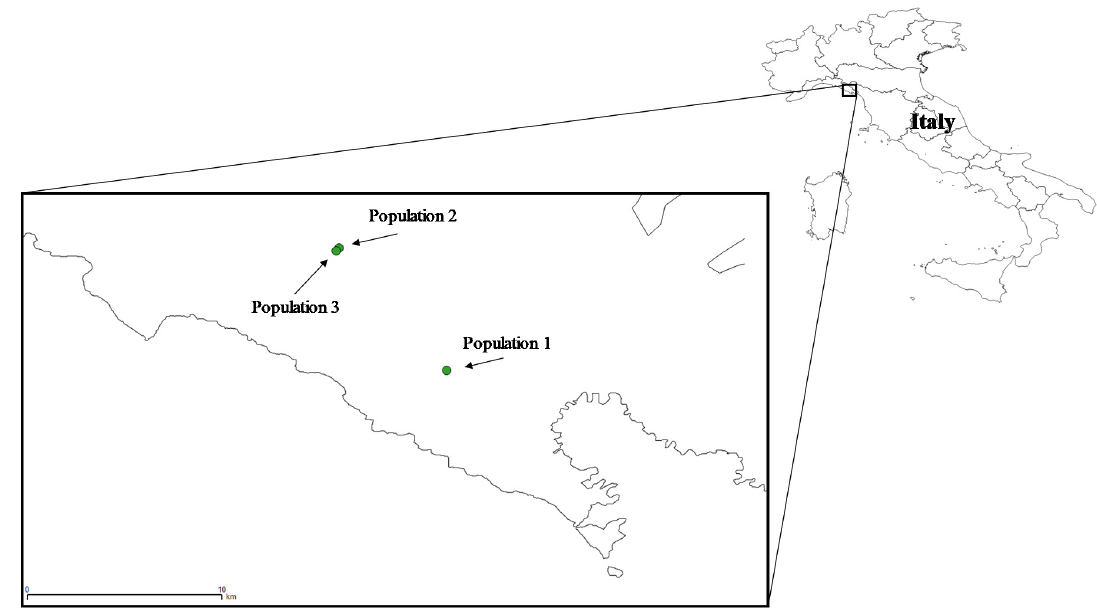
Figure 1. Location of the three studied populations of Hydromantes ambrosii . Green circles indicate the monitored caves. Further details are not shown for species protection [46] .